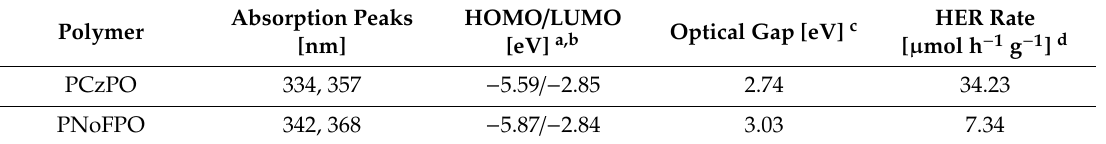
Table 1. UV-vis absorption peaks, HOMO / LUMO energy levels, optical gap and hydrogen evolution rate (HER rate) using PCzPO and PNoFPO D-A